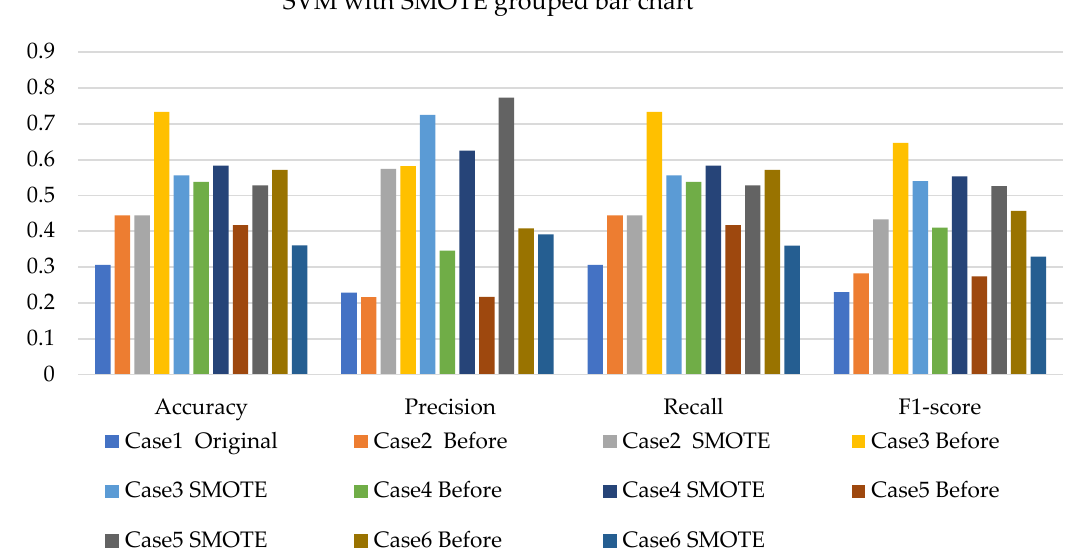
Figure 8. Simulation performance of SVM classification with SMOTE.